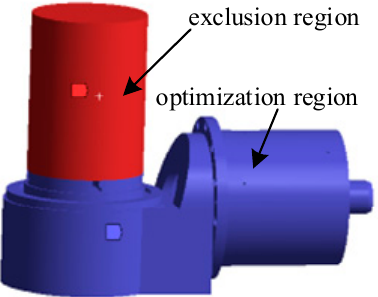
Figure 6. Optimization and exclusion regions of topology optimization.